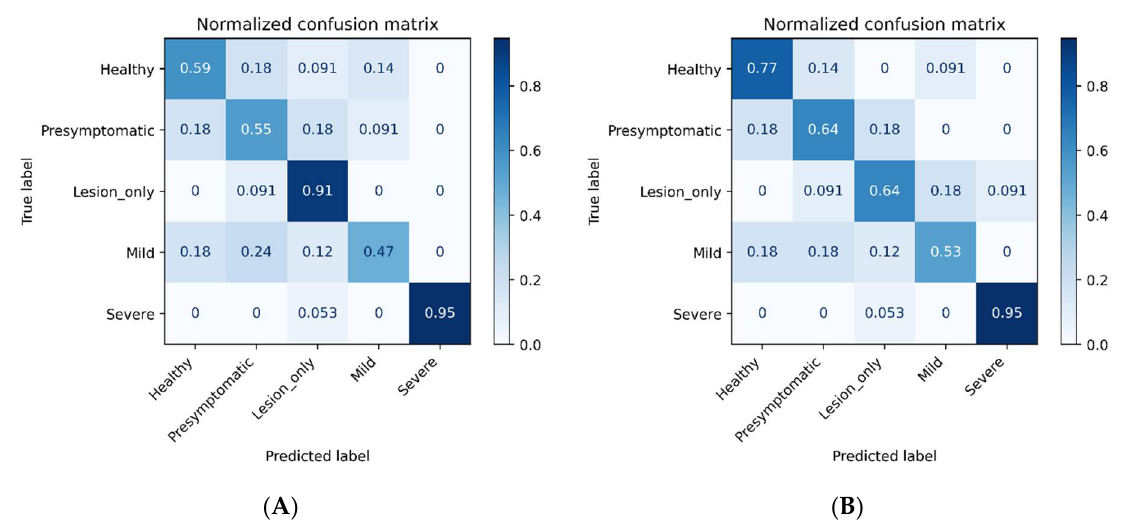
Figure 7. Confusion matrixes using all wavelengths ( A ) and the selected top-10 wavelengths ( B ) to classify mock-inoculated healthy peanut plants and plants inoculated with Athelia rolfsii at different stages of disease development. Feature selection method = recursive feature elimination with an estimator of the support vector machine, the linear kernel (RFE-SVML); Classifier = SVML.